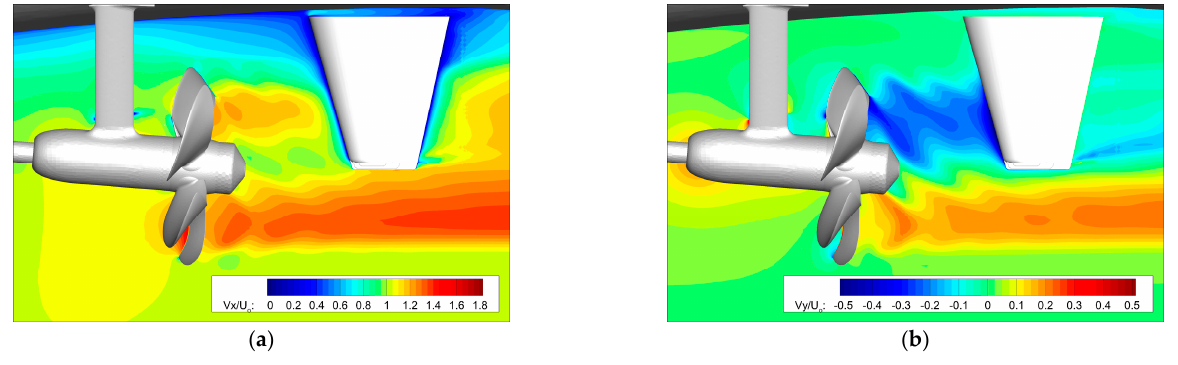
Figure 7. Instantaneous axial and transverse velocity distributions on the longitudinal plane passing the nose-tail line of the port side flat rudder at δ R = 0°and 26 knot ship speed: ( a ) axial velocity distribution; ( b ) transverse velocity distribution.